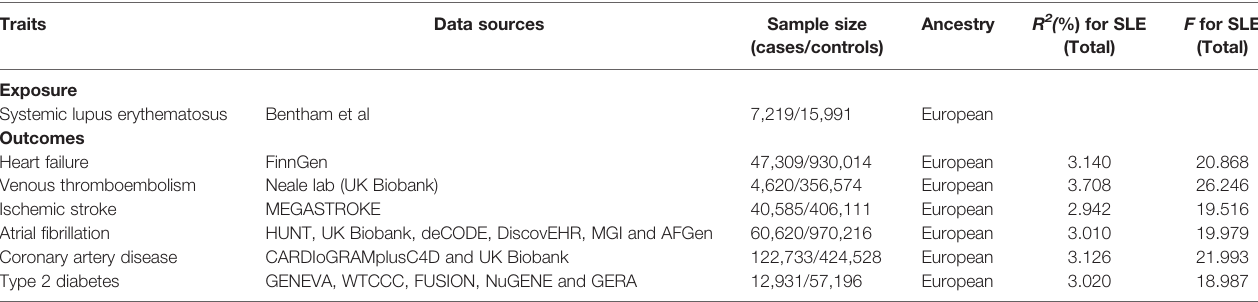
TABLE 1 | Data sources and instrumental variables strength assessment. Traits Data